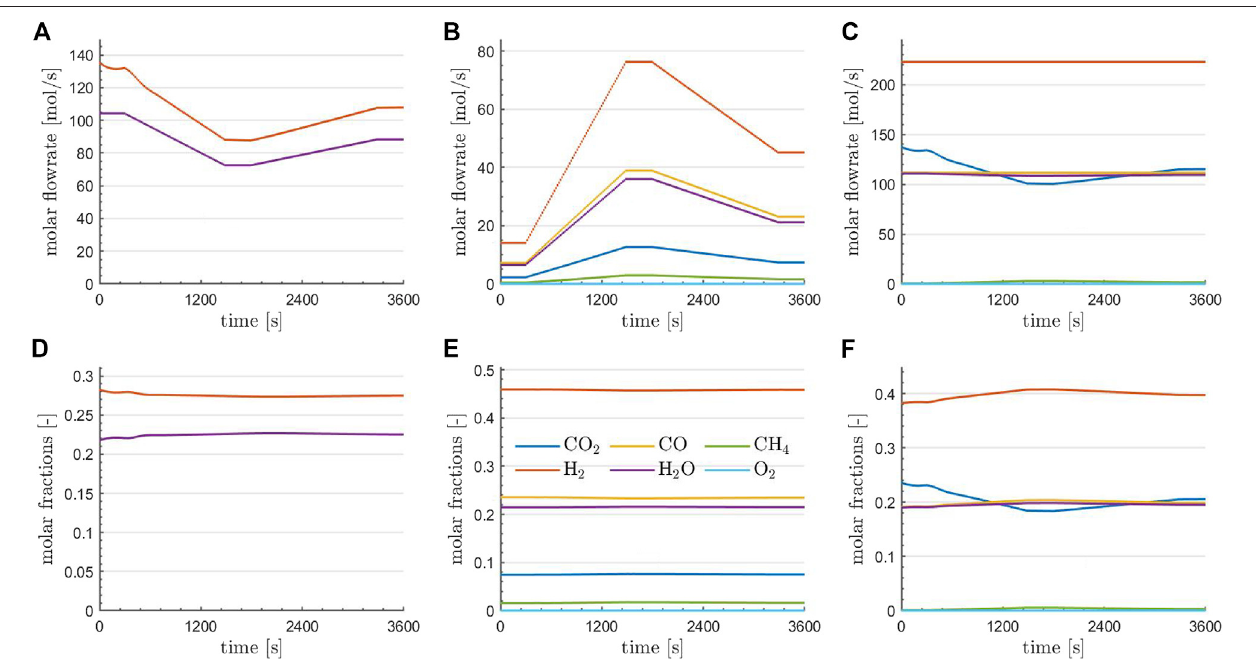
FIGURE 5 | Flowrates (A – C) and compositions (D – F) of the various species at the RWGS reactor outlet (A , D) , the TRI reactor outlet (B , E) , and at the combined plant outlet (C , F) at optimality for the optimal solution obtained using parareal .